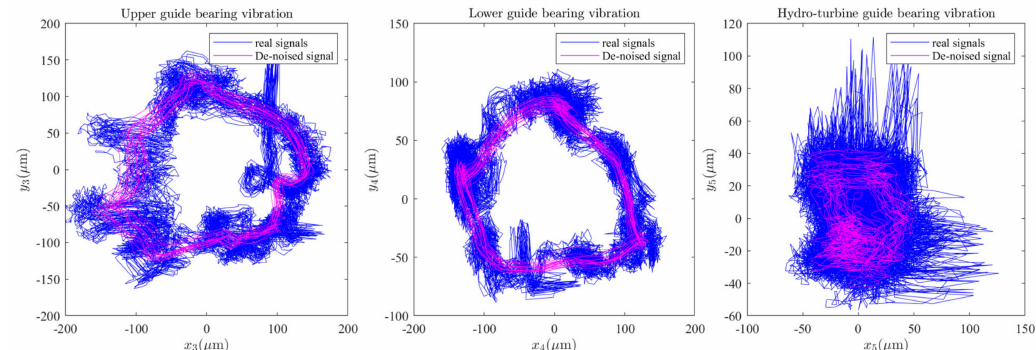
Figure 8. Shafting vibration before and after denoising.